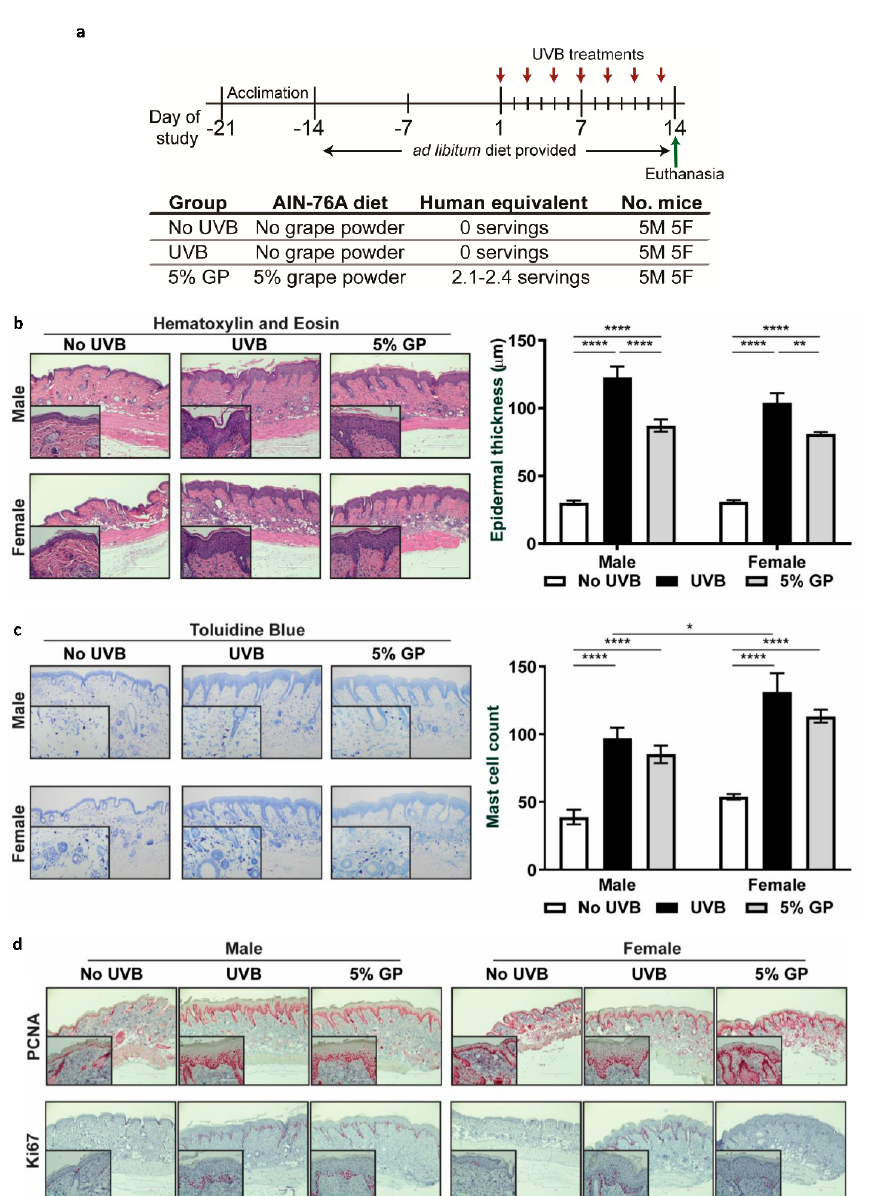
Figure 1. Dietary GP consumption results in UVB-mediated cutaneous hyperplasia and mast cell infiltrations in SKH-1 hairless mice. ( a ) Timeline of short-term UVB-mediated cutaneous damage study. ( b ) GP consumption significantly reduced epidermal thickness as determined by measuring epidermal thickness from the base of the stratum basale to the base of the stratum corneum on H&E-stained tissue sections. ( c ) Mast cell infiltration shown by toluidine blue staining. At least five images were taken at 10x magnification across five different skin sections of each mouse. Mast cells (violet metachromatic cytoplasmic granules) were counted using ImageJ, and then averaged per mouse. ( d ) Expression of proliferative markers PCNA and Ki67 was assessed using immunohistochemical staining techniques. Representative sections are shown. All images are represented at 10 × magnification, with inset at 40 × magnification. The data represent the mean ± SEM of all five animals per group. A two-way ANOVA with Tukey’s multiple comparison test was performed (* p < 0.05, ** p < 0.01, **** p <